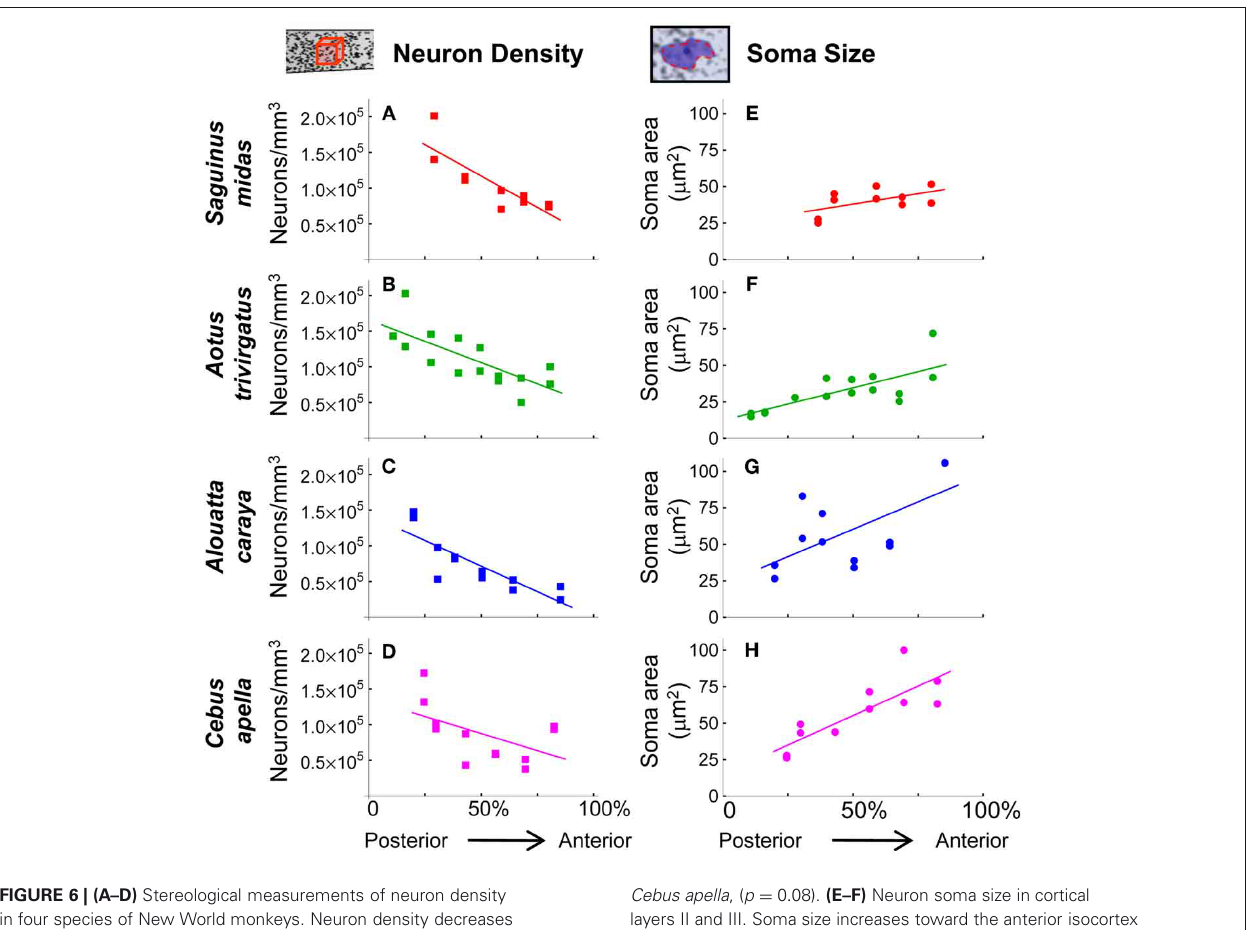
FIGURE 6 | (A–D) Stereological measurements of neuron density in four species of New World monkeys. Neuron density decreases toward the anterior. Linear regression confirms the high significance ( p < 0 . 002, one-tailed t -test) of the trend in (A,B, and C) . For (D) ,